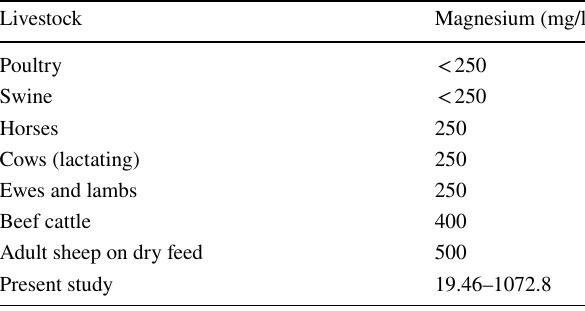
Table 14 Suggested magnesium levels for livestock drinking water Table 15 Livestock drinking water and irrigation guidelines for toxic